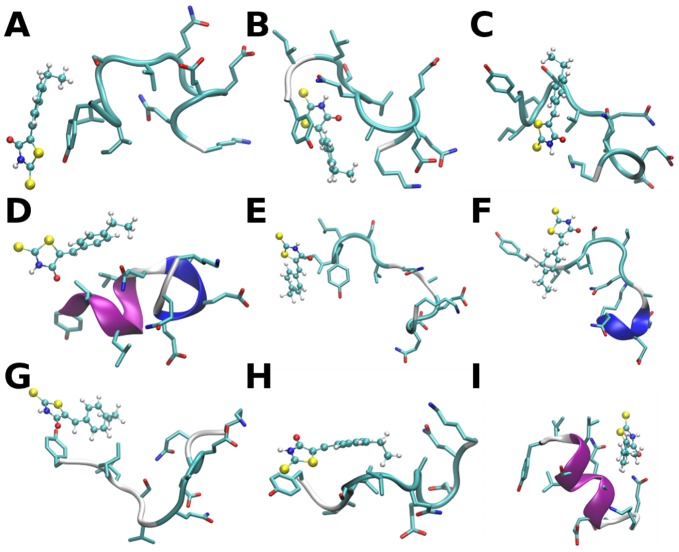
Representative conformations from the computed equilibrium ensemble for the c-Myc402–412/1 complex.The conformations depicted are those closest to the cluster center. The fractional cluster populations are: 0.021±0.008 (A), 0.019±0.002 (B), 0.018±0.005 (C), 0.015±0.010 (D), 0.014±0.003 (E), 0.011±0.008 (F), 0.011±0.005 (G), 0.011±0.001 (H), 0.010±0.003 (I). Figure prepared with the software VMD [78].